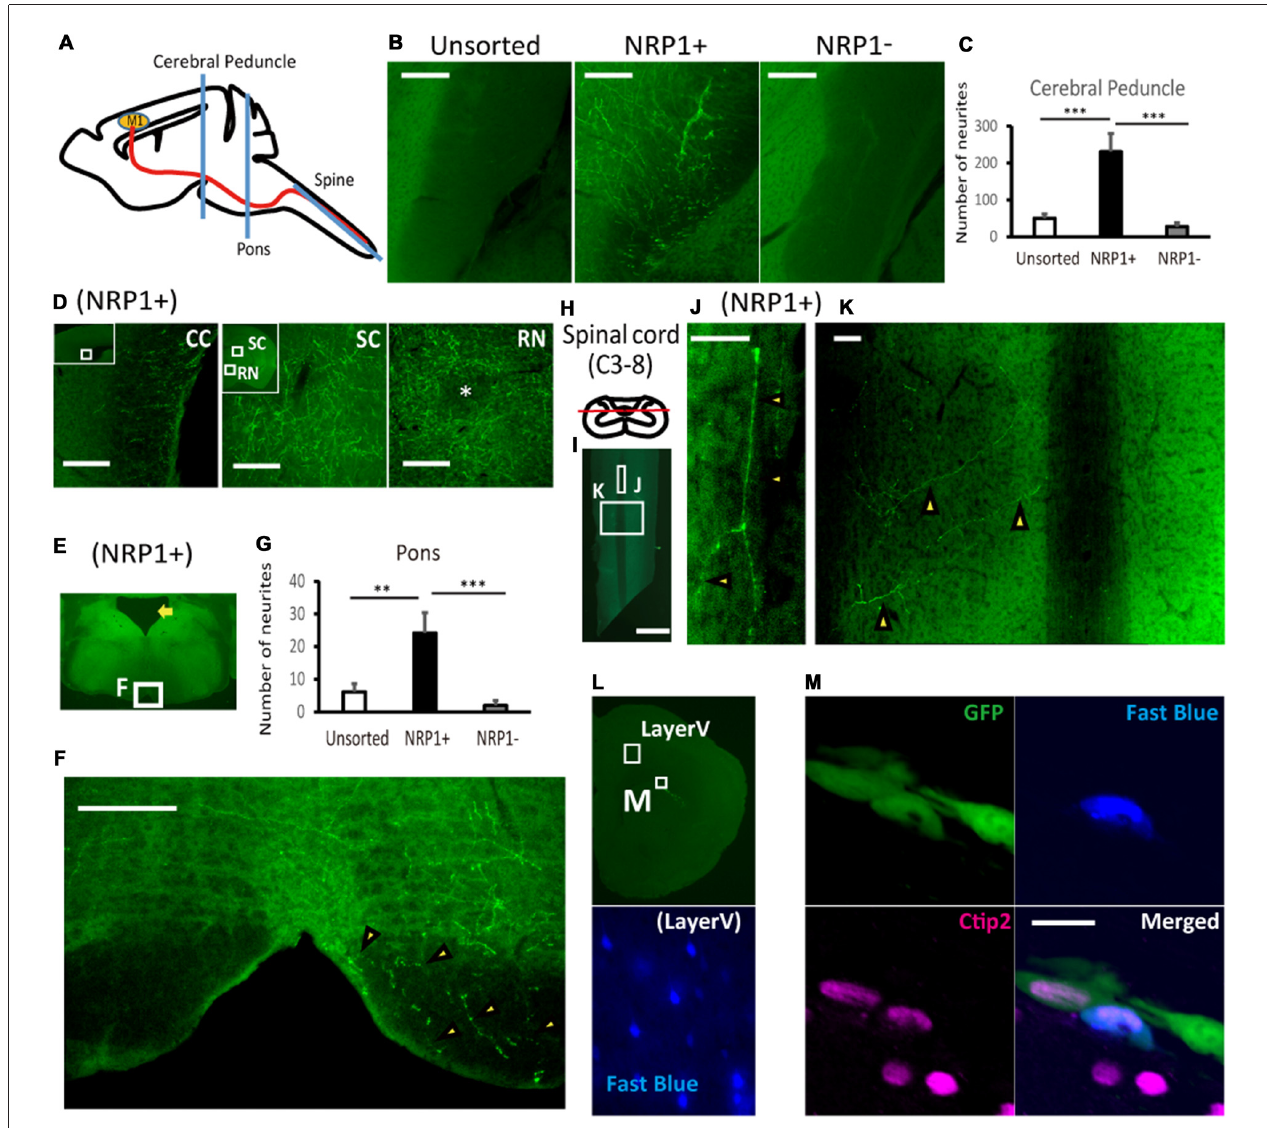
FIGURE 5 | NRP + cell-derived grafts project more neurites along the corticospinal tract (CST) to the spinal cord. (A) Schematic diagram of the section line at the cerebral peduncle, pons and spinal cord. M1, primary motor cortex. (B) Representative images of GFP + neurites (green) at the cerebral peduncle in NRP1 + , NRP1 − and unsorted cells. Scale bars, 100 µ m. (unsorted, n = 12; NRP1 + , n = 12; NRP1 − , n = 12). (C) Enumeration of GFP positive neurites at the internal capsule. Values are the mean ± SEM. F ( 2,33 ) = 13.7, p < 0.0001. ∗∗∗ p < 0.001 by one way ANOVA followed by Tukey’s post hoc test. (D) Representative images of GFP + neurites in the contralateral corpus callosum (CC), around the ipsilateral superior colliculus (SC) and red nucleus (RN) in the NRP1 + group. Scale bars, 100 µ m. (E) Low power image of the pons. The arrow indicates the 4th ventricle. (F) Representative figures of GFP + neurites (arrowheads) at the lower pons in the NRP1 + group. Scale bar, 100 µ m. (G) Enumeration of GFP + neurites at the pons. Values are the mean ± SEM. F ( 2,33 ) = 9.3, p = 0.0006. ∗∗ p < 0.01 and ∗∗∗ p < 0.001 by one way ANOVA followed by Tukey’s post hoc test. (unsorted, n = 12; NRP1 + , n = 12; NRP1 − , n = 12). (H) Schematic diagram of the section line parallel to the pyramidal tract in the posterior column. (I) Low power image of the cutting plane including the posterior column of the spinal cord (C3-Th2). Scale bar, 1000 µ m. (J,K) High power image of (J) the posterior column and (K) right spinal layer. Arrowheads indicate GFP + neurites, and there was no neurites in the left spinal layer. Scale bars, 50 µ m. (unsorted, n = 12; NRP1 + , n = 12; NRP1 − , n = 12). (L) Low power image of left frontal cortex. An appropriate injection of fast blue was confirmed at layer V neurons as positive control. (M) High power image of the graft in (L) . Immunostaining for GFP (green)/Ctip2 (magenta)/Fast blue (blue). Scale bars, 25 µ